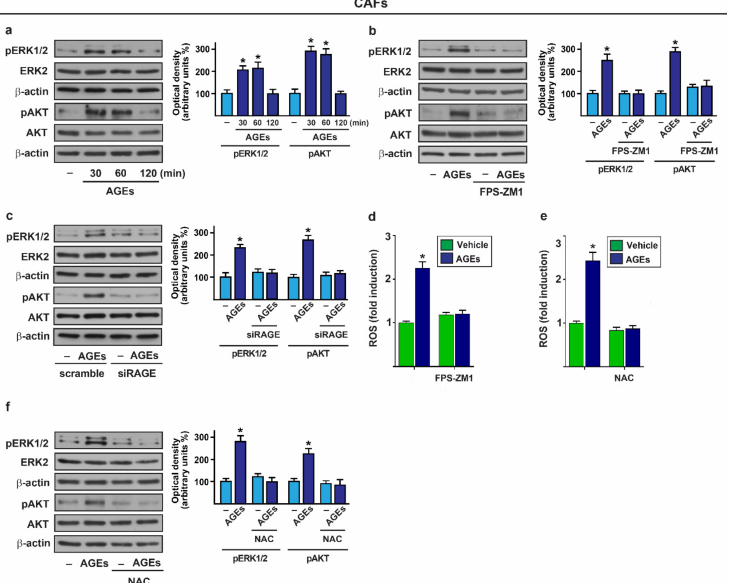
Figure 1. AGEs trigger rapid responses via RAGE in CAFs. ( a ) Phosphorylation of ERK1/2 and AKT in CAFs exposed to vehicle (–) and 100 µ g/mL AGEs for the indicated times; ( b ) Phosphorylation of ERK1/2 and AKT in CAFs treated for 30 min with vehicle (–) or 100 µ g/mL AGEs alone and in the presence of 1 µ M RAGE inhibitor FPS-ZM1; ( c ) Immunoblots of ERK1/2 and AKT in CAFs transfected with scramble siRNA or siRAGE (10 nM) for 24 h and then treated for 30 min with vehicle (–) and 100 µ g/mL AGEs; ( d , e ) ROS generation in CAFs exposed to vehicle and 100 µ g/mL AGEs alone or in the presence of 1 µ M RAGE inhibitor FPS-ZM1 and 300 µ M free radical scavenger N-acetyl-Lcysteine (NAC), as indicated. The values of fluorescent probe DCF-DA obtained in CAFs treated with vehicle was set as one-fold induction upon which ROS levels induced by AGEs were calculated. Values represent the mean ± SD of three independent experiments performed in triplicate; ( f ) The activation of ERK1/2 and AKT in CAFs upon 100 µ g/mL AGEs exposure for 30 min was abolished using 300 µ M free radical scavenger NAC. ERK2 and AKT were used as loading control, as indicated. Side panels show densitometric analysis of the blots normalized to the loading controls. Values represent the mean ± SD of three independent experiments. (*) indicates p <